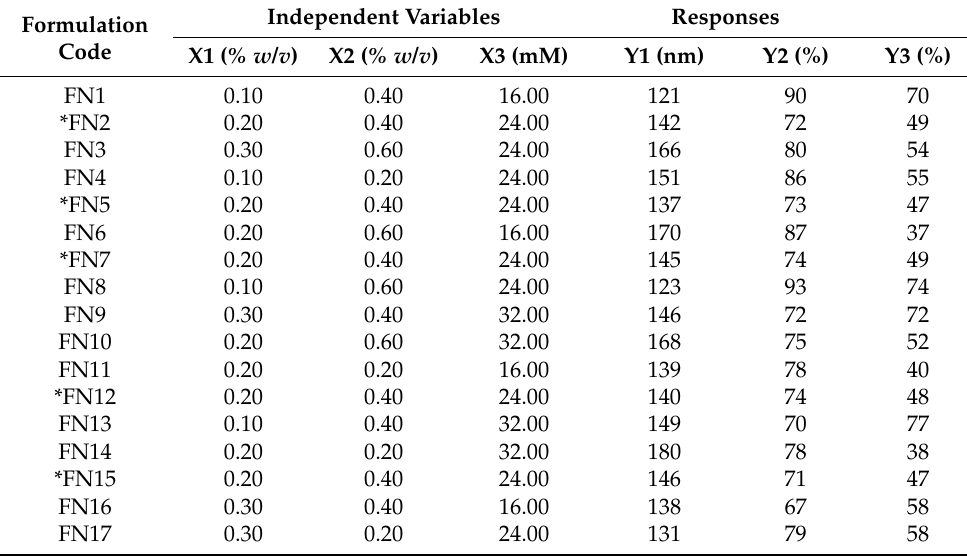
Table 2. The in vitro investigated results of different formulations (FN1-FN17) for responses Y1, Y2, and Y3 in Box Behnken design for optimization of β -Sitosterol-loaded Alg/Ch-NPs-FA.